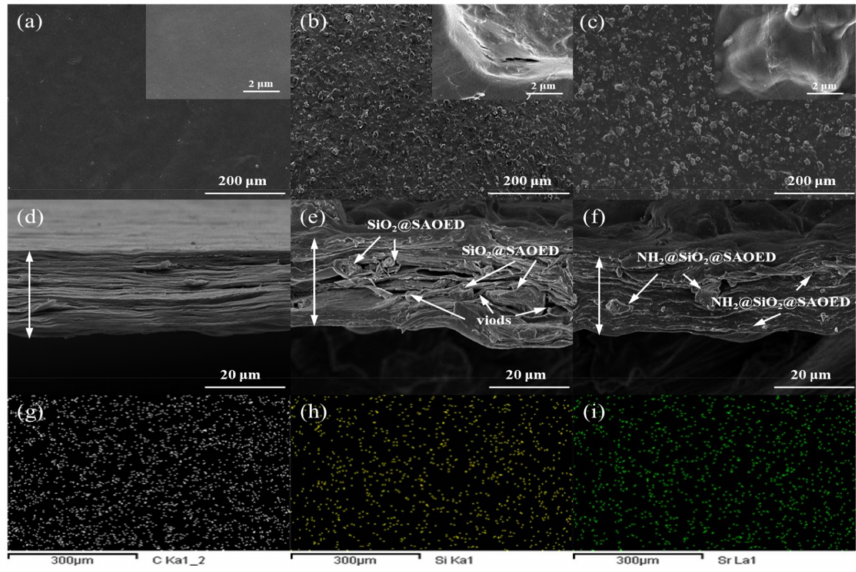
Figure 6. Typical micromorphology and particle dispersion of ONFC luminescent films: SEM morphologies of the surface and the cross-section of ( a , d ) ONFC film (inset: high magnification image of composite film); ( b , e ) ONFC luminescent film with SiO 2 @SAOED (mass ratio = 1/1); and ( c , f ) ONFC luminescent film with NH 2 @SiO 2 @SAOED phosphors (mass ratio = 1/1); EDS-mapping patterns of luminescent film with NH 2 @SiO 2 @SAOED phosphors after scanning the characteristic elements of ( g ) carbon; ( h ) silicon; and ( i )